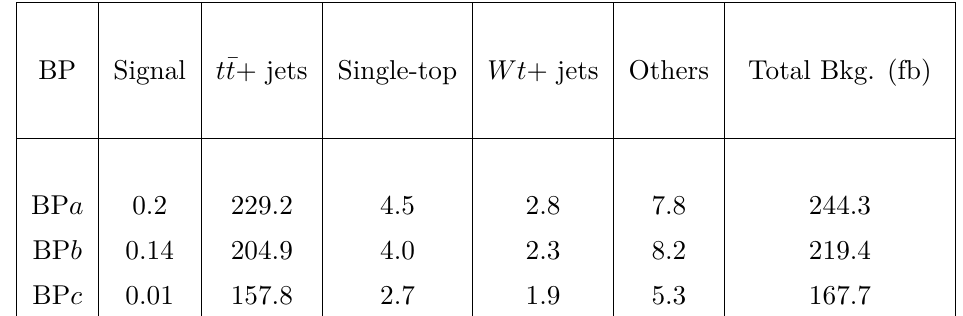
Table 6 . The cross sections (in units of fb) of three BPs and the different background components for the 4 b 1 ‘ process after selection cuts at